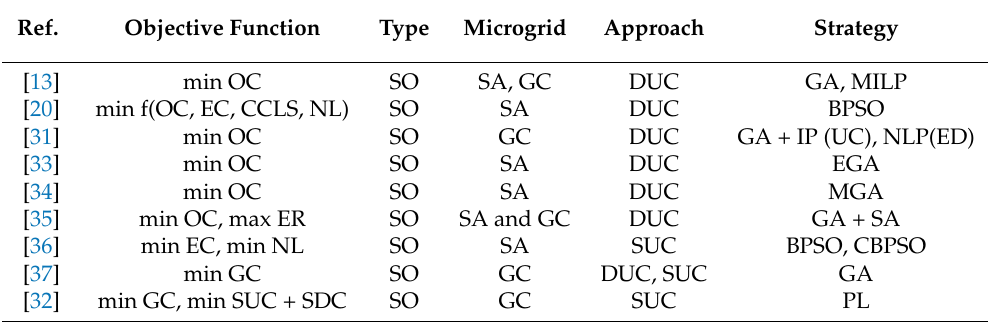
Table 1. Relevant literature in optimization of microgrids. Objective Function: Operation Cost (CO), Emission Cost (EC), Compensation Cost of Load Shedding (CCLS), network loss (NL), Economical Revenue (ER). Type: Single Objective. Microgrid: Standalone (SA), Grid Connected Genetic Algorithm (GA), Enhanced Genetic Algorithm (EGA), Integer Programming (IP), Non-Linear Programming (NLP), Simulated Annealing (SA), Mixed Integer Linear Programming (MILP),